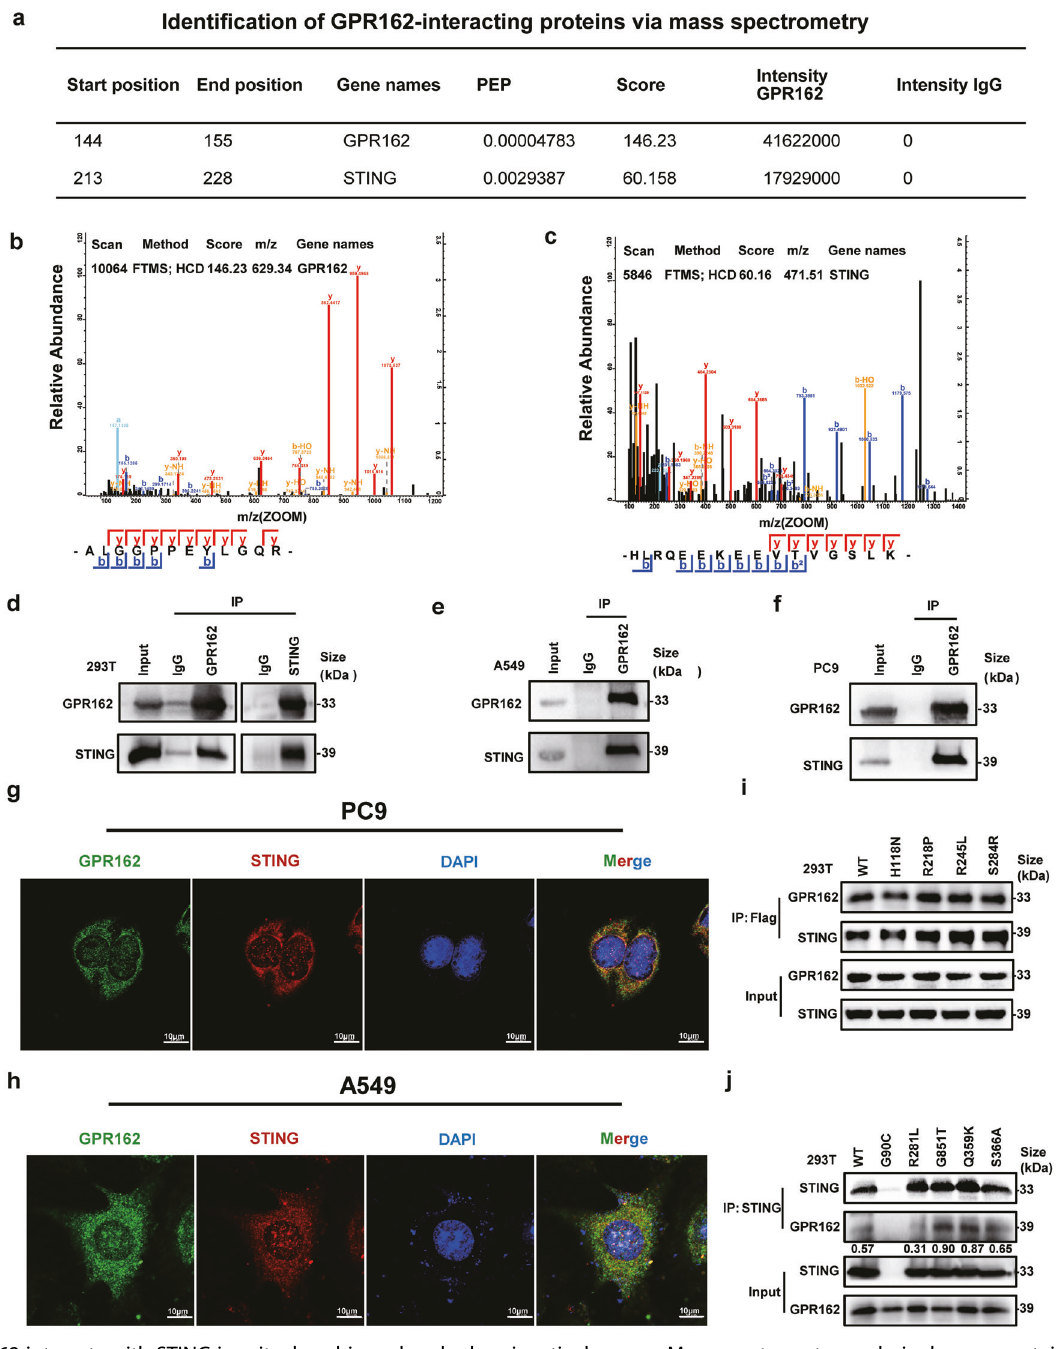
Fig. 1 GPR162 interacts with STING in mitochondria and endoplasmic reticulum. a – c Mass spectrometry analysis shows a protein interaction between GPR162 and STING. d GPR162 and STING were simultaneously transfected into 293T cells, and the interaction between GPR162 and STING was detected by Co-IP analysis, IgG was the negative control. e , f IP identi fi cation of endogenous GPR162 and STING interactions in A549 ( e ) and PC9 ( f ) parent cells, IgG was the negative control. g , h Confocal microscopy images of A549 ( h ) and PC9 ( g ) stained with anti- GPR162, anti-STING antibodies, and DAPI. Scale bar, 25 μ m. i The interaction between GPR162 and STING was detected by IP analyses in 293T cells transfected with GPR162 WT and mutant plasmids including H118N, R218P, R245L, and S284R. j The interaction between